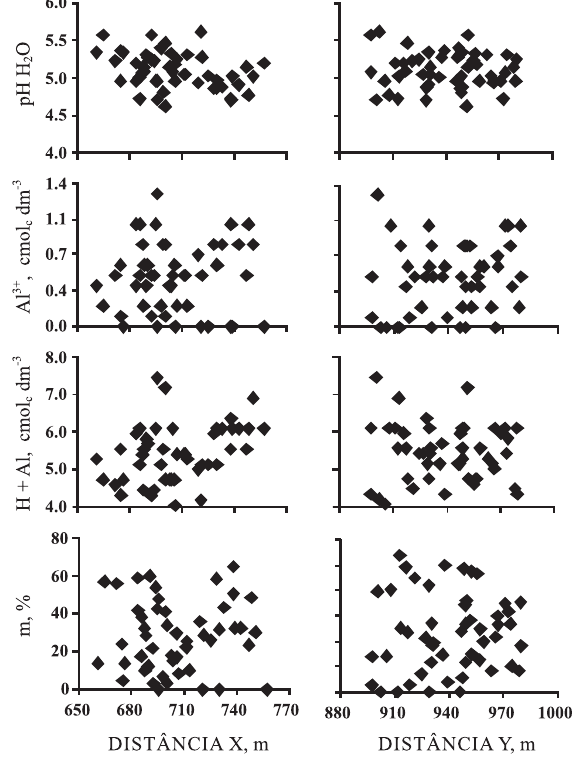
Figura 3. Dispersão dos dados de acidez em função das coordenadas X e Y.